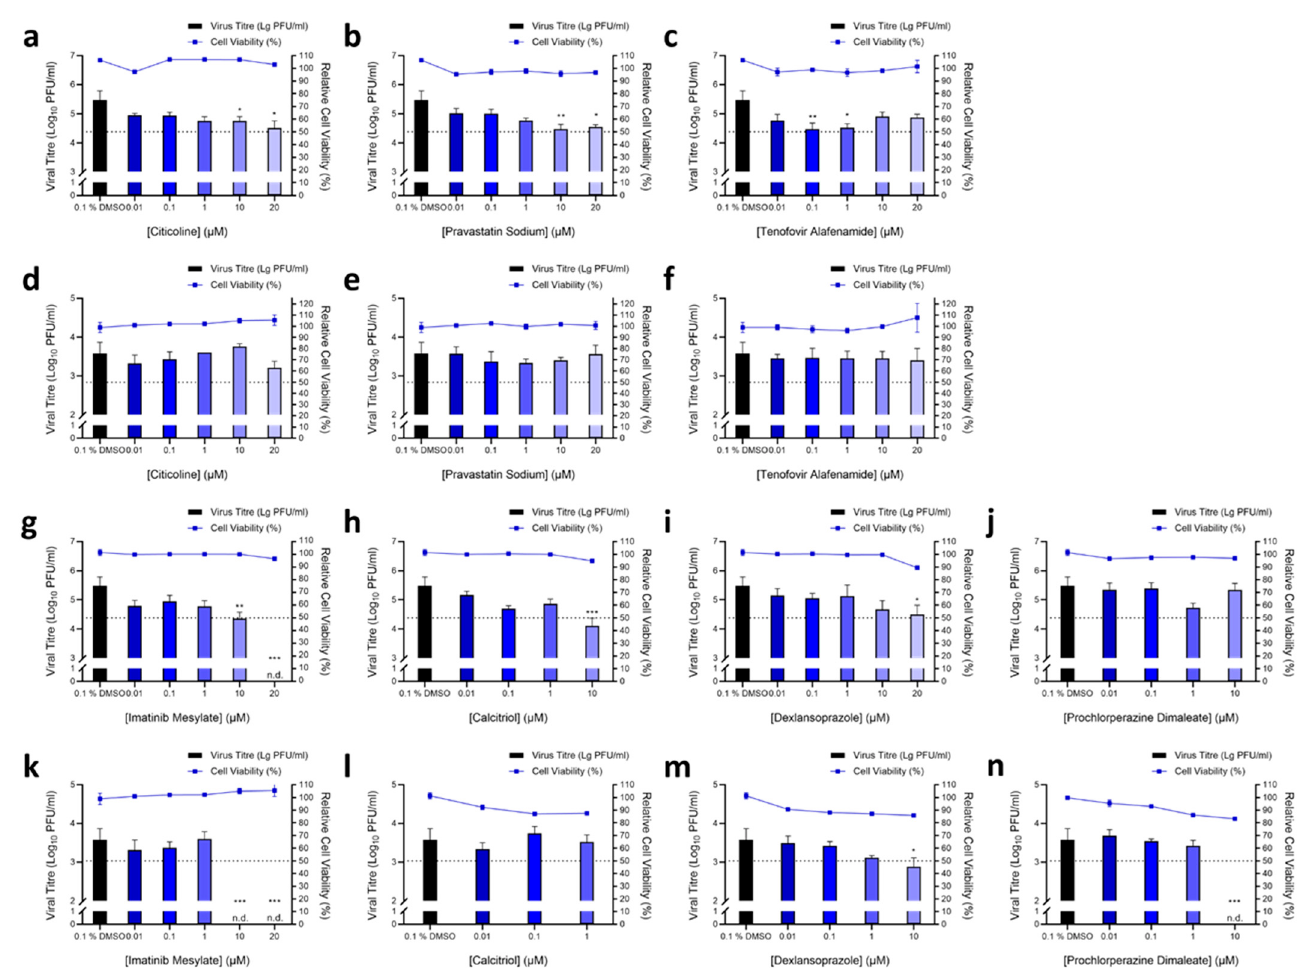
Figure 2. Validation of primary hits. For validating compounds with activity pre-infection, Vero E6 cells were first pre-treated with increasing concentrations of ( a ) citicoline, ( b ) pravastatin sodium and ( c ) tenofovir alafenamide prior to infection with SARS-CoV-2. Similarly, Huh7 cells were pre-treated with ( d ) citicoline, ( e ) pravastatin sodium and ( f ) tenofovir alafenamide and subsequently infected with SARS-CoV-2. For post-infection treatment validation, Vero E6 cells were infected with SARS-CoV-2 and treated with increasing concentrations of ( g ) imatinib mesylate, ( h ) calcitriol, ( i ) dexlansoprazole and ( j ) prochlorperazine dimaleate. Similarly, HuH7 cells were also infected then treated with a range of concentrations of ( k ) imatinib mesylate, ( l ) calcitriol, ( m ) dexlansoprazole and ( n ) prochlorperazine dimaleate. The primary and secondary exes correspond to the viral titre and relative cell viability, and the dashed line represents the CC 50 cut-off for cell viability. One-way ANOVA and Dunnett’s post-test were used to determine statistical differences, with * denoting p < 0.05, ** denoting p < 0.01 and *** denoting p < 0.001. Error bars represent the standard deviation observed from the means of triplicates performed for both cell viability and dose-dependent inhibition